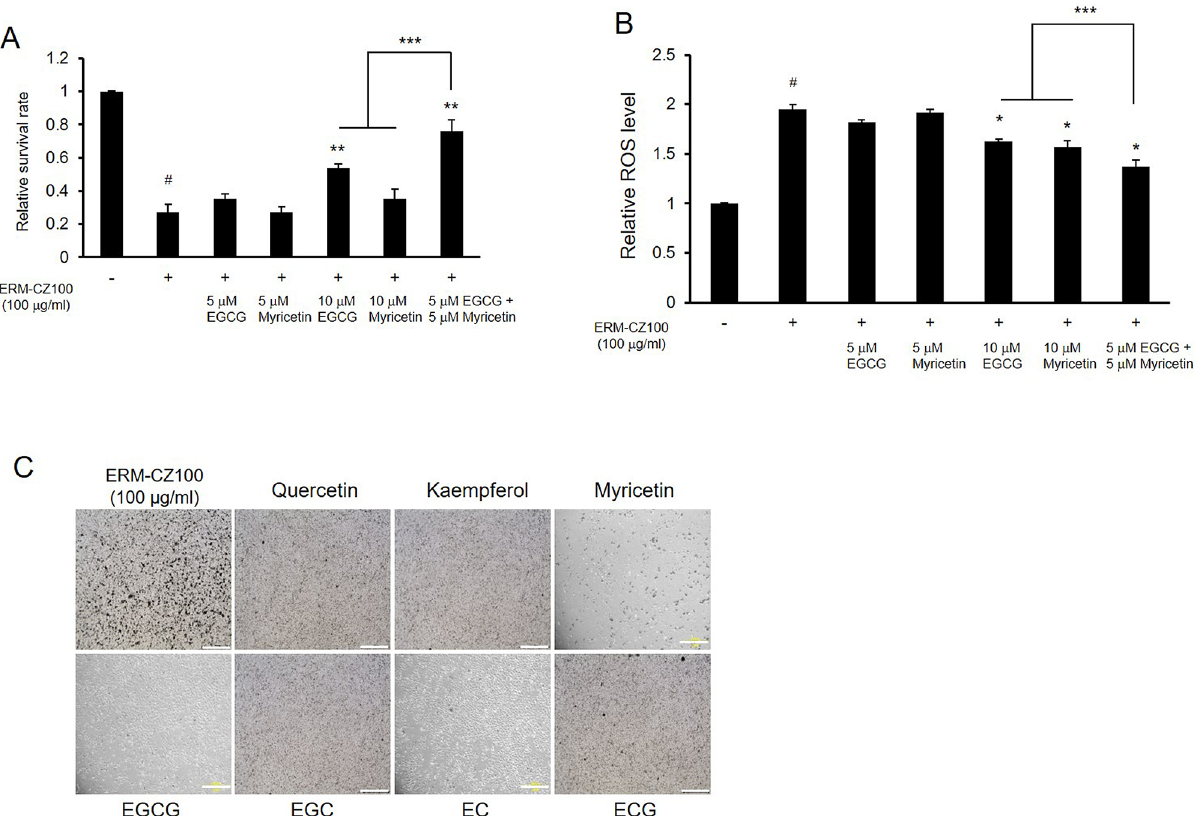
Figure 3. Synergistic effects of EGCG and myricetin against FDP-induced cellular damage. ( A ) Combined protective effects of EGCG and myricetin on cell survival under FDP treatment. ( B ) Synergistic ROS-scavenging effects of EGCG and myricetin in FDP-stimulated BEAS-2B cells. ( C ) Effects of green tea catechins and flavonols on the morphology of FDP-treated cells. The results are shown as the means ± SDs of the values obtained in 3 independent experiments (N = 3). * p < 0.05 and ** p < 0.001 compared to the FDP-treated group; *** p < 0.01 compared to the 10 μM alone treatment vs. 5 μM combined treatment; # p < 0.001 compared to the vehicle control group. Scale bars, 200